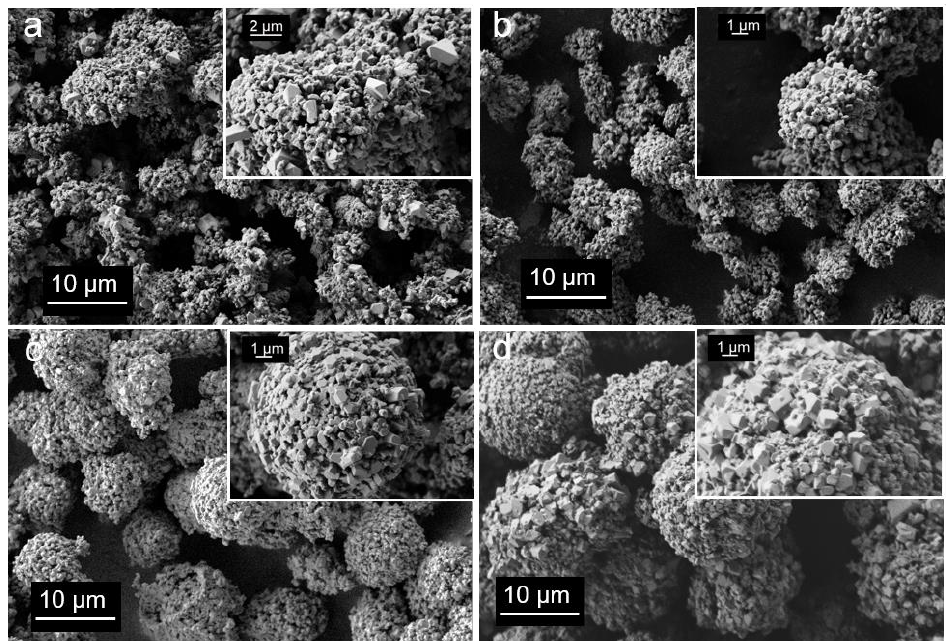
Figure 1. SEM micrographs of the cathode materials at different magnifications: ( a ) LMR20, ( b ) LMR35, ( c ) LMR50, and ( d ) LMR65. The differential size distributions for the cathode materials are shown in Figure S2.